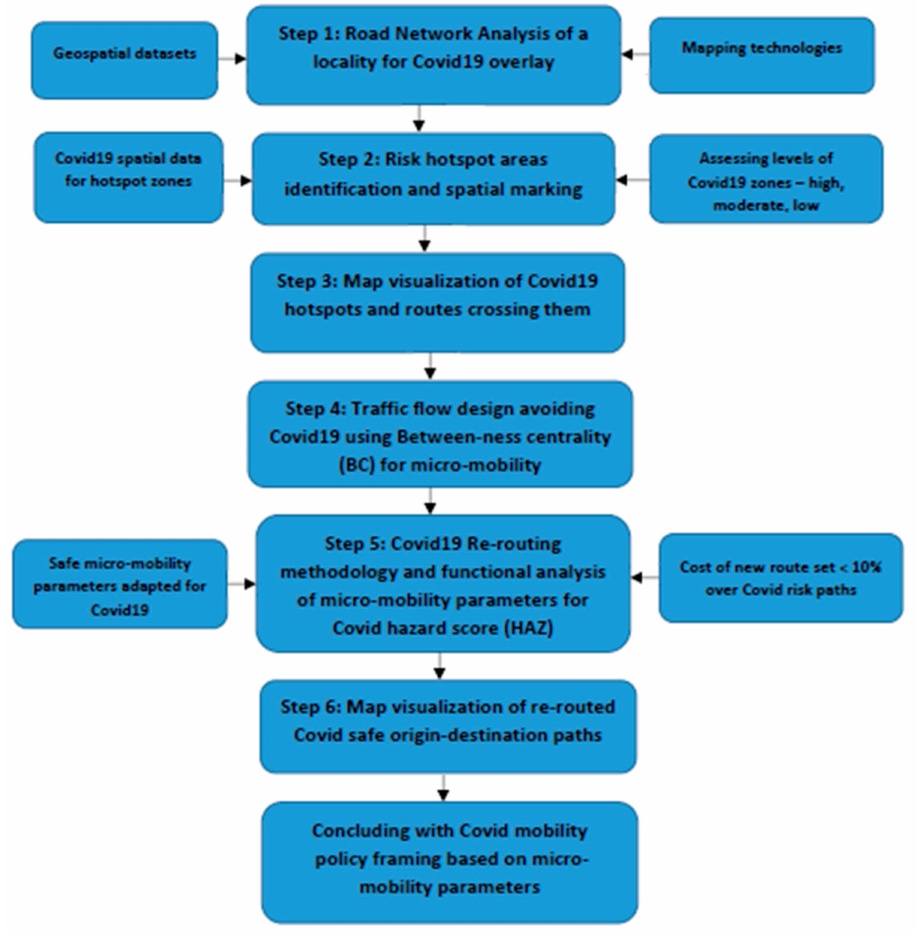
Figure 2. An overview of the steps followed in the study for safe micro-mobility in pandemic, starting with data collection, spatial analysis, situation determination, and new route